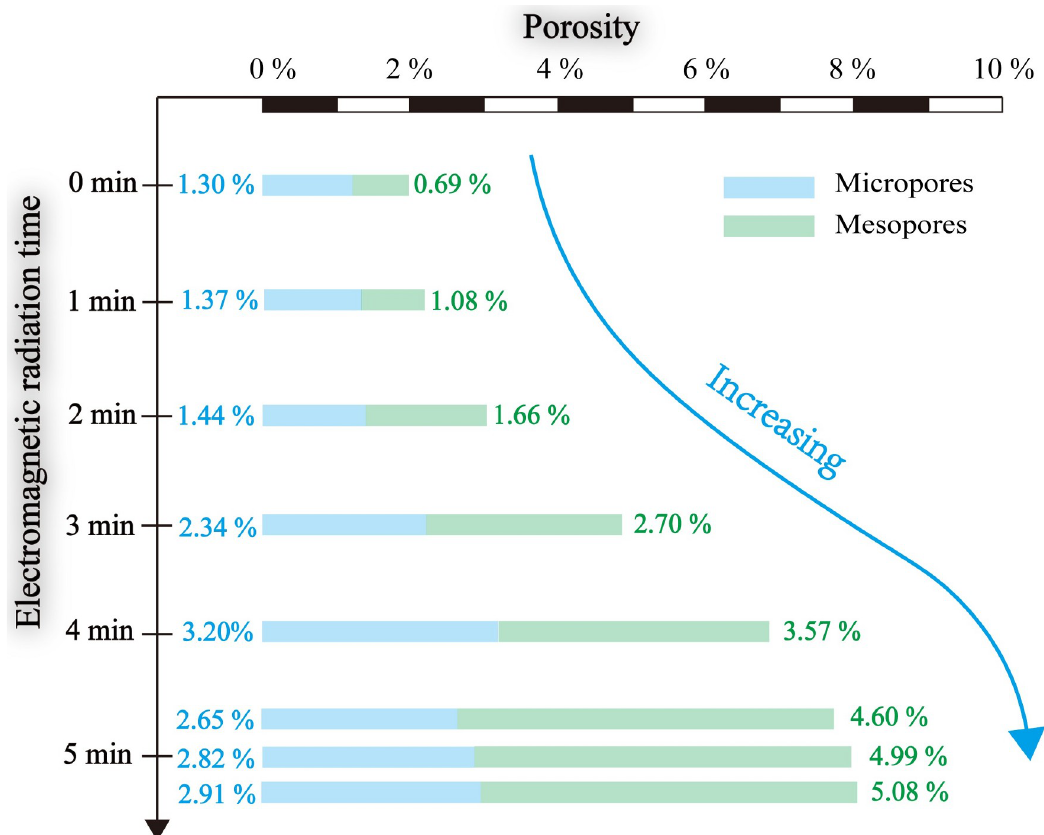
Fig 8. The variation of porosity of marine shale samples at different electromagnetic radiation